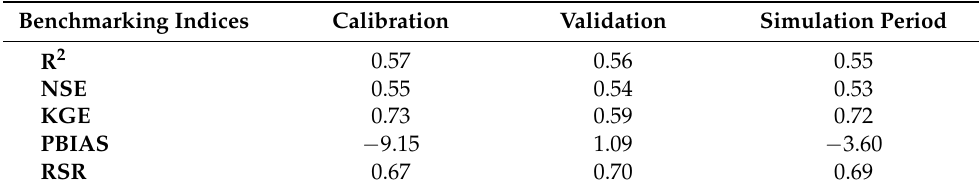
Table 3. General model performance